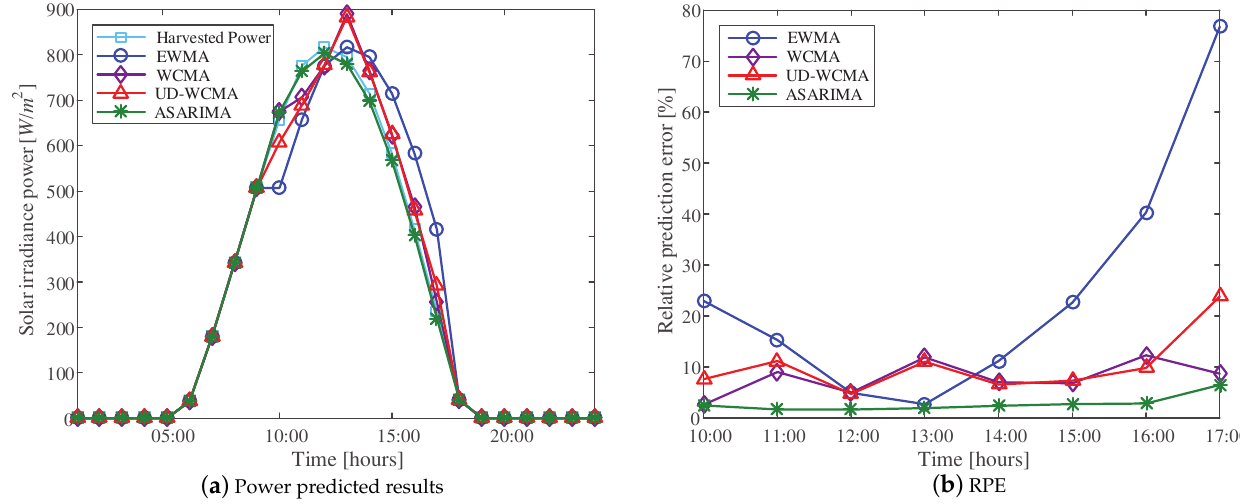
Figure 6. Power predicted and prediction error for 14 April